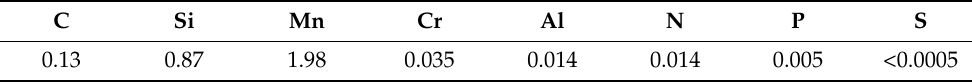
Table 1. Chemical composition (wt%) of DP780 steel measured using